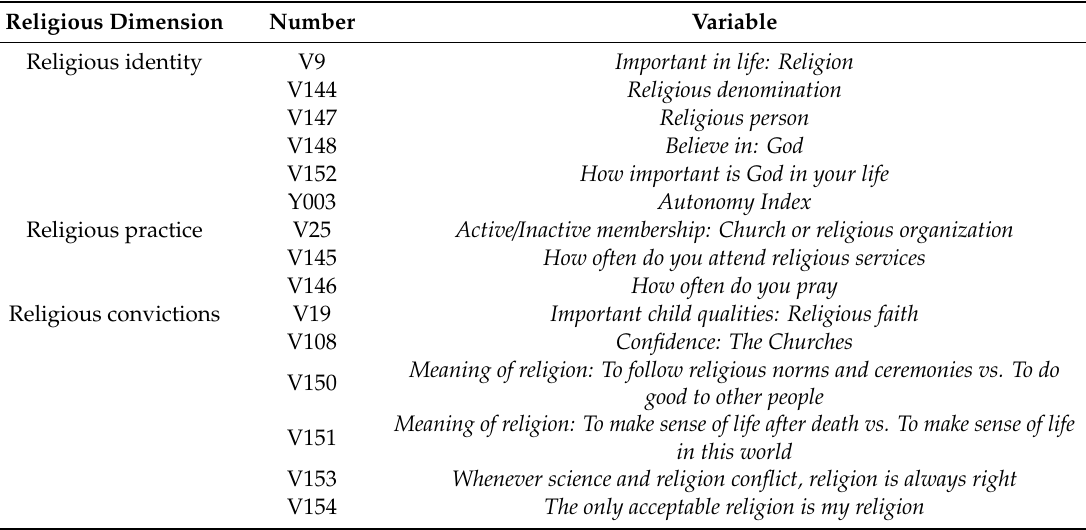
Table 2. Dependent